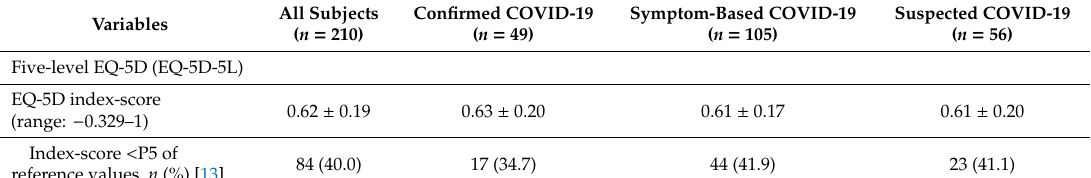
Table 2. EQ-5D-5L and CCQ